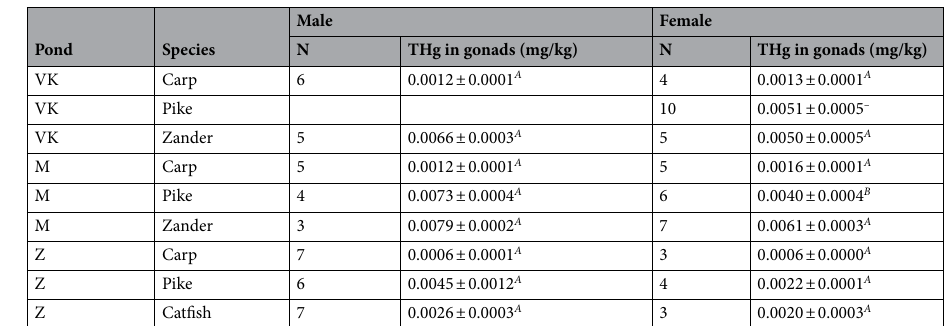
Table 3. Total mercury content THg (mg/kg wet weight; mean ± standard error of mean) in the gonads of male and female carp, pike, zander and catfish caught in three ponds: Velky Kocelovicky (VK), Mysliv (M) and Zehunsky (Z). Total mercury content in the gonads of males and females followed by the same capital letter in italics in the row did not differ significantly (Tuckey post hoc test in factorial